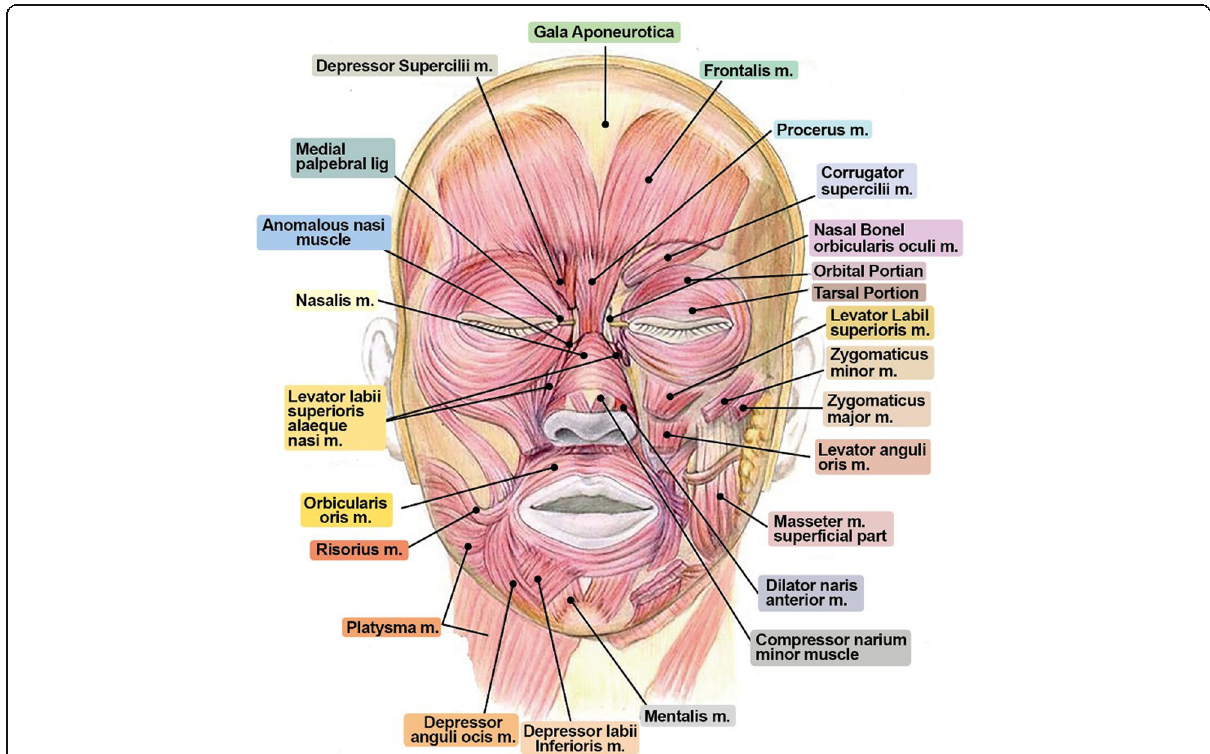
Fig. 3 Perform botulinum toxin injection after understanding the overall anatomical structures for facial muscles. In particular, carefully look for orientation of frontalis, procerus, and masseteric